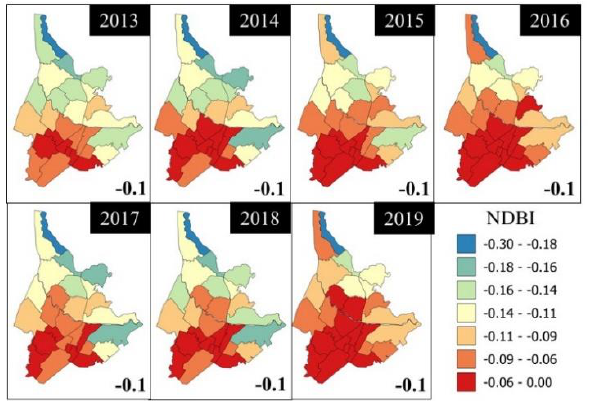
Figure 5. Barangay-level average NDBI maps of Mandaue City